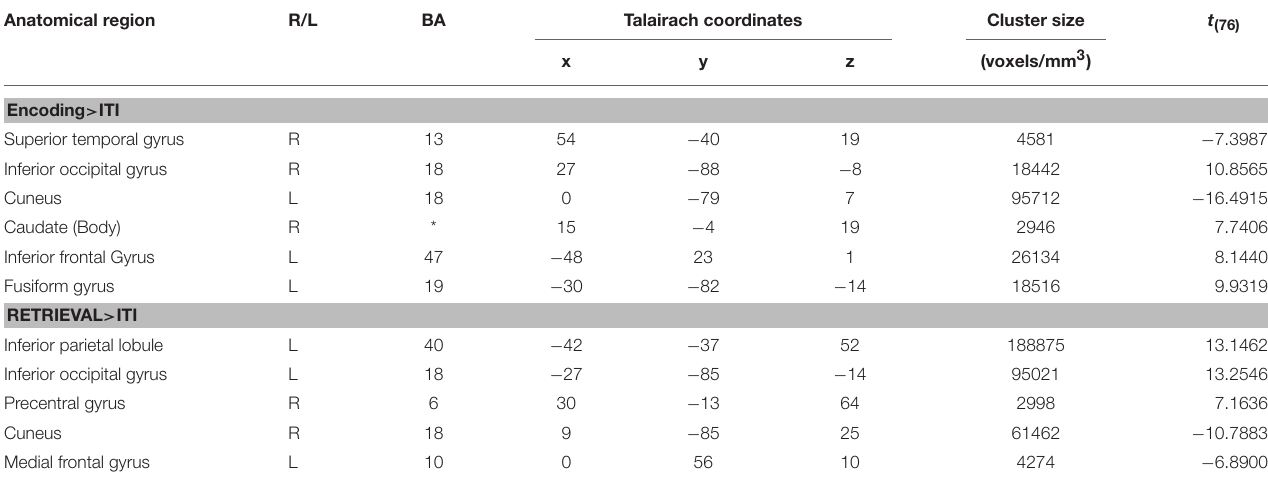
TABLE 2 | Main effect for successful encoding ( > ITI) and successful retrieval ( > ITI) for the whole sample using linear contrasts ( t -statistics). Anatomical region R/L BA Talairach coordinates Cluster size x y z (voxels/mm 3 )